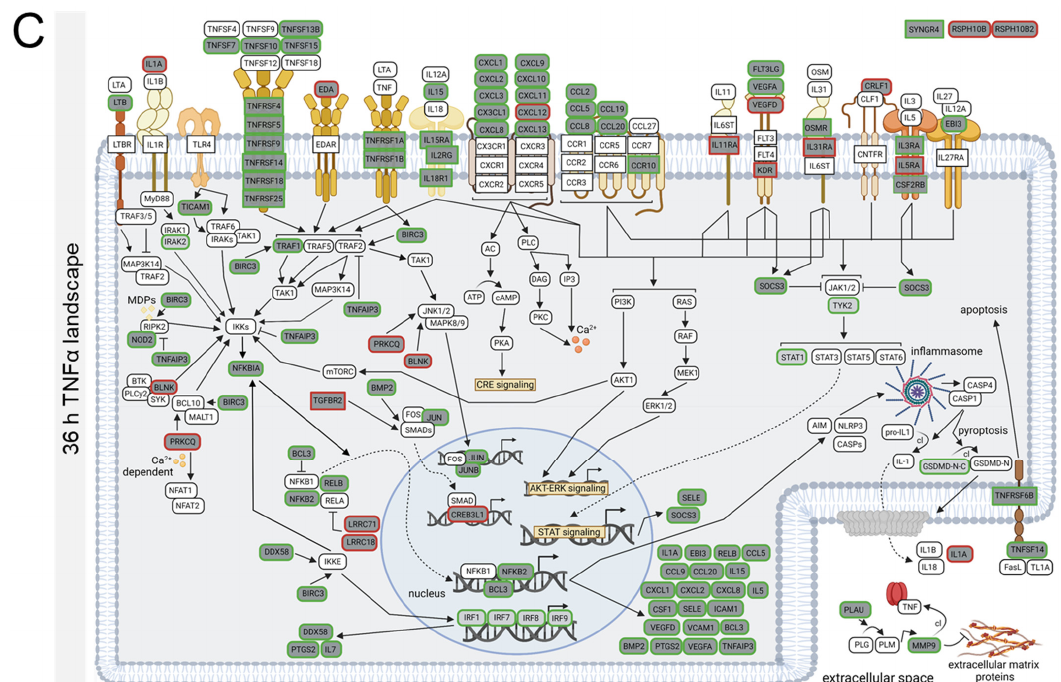
Figure 2. Molecular landscapes of the proteins encoded by the differentially expressed genes (DEGs) from the three core KEGG pathways (“Cytokine-cytokine receptor signaling”, “TNF signaling” and “NF κ B signaling”) following TNF α stimulation of human cortical spheroids for ( A ) 4 h, ( B ) 12 h and ( C ) 36 h. Protein functions and interactions were deduced based on information obtained from Uni- protKB (https://www.uniprot.org/; accessed on 1 January 2022) and Genecards (https://www.gene- cards.org; accessed on 15 January 2022). A detailed description of the protein-protein interactions occurring in these molecular landscapes can be found in Supplementary information S5. Rectangu- larly framed protein: membrane-bound receptor; protein in green or red (rounded) rectangle frame: encoded by an up- or downregulated DEG, respectively; protein in dark-gray-filled (rounded) rec- tangle: encoded by a core KEGG pathway DEG; protein in light-gray-filled (rounded) rectangle: encoded by a DEG not in the core KEGG pathways; protein in white-filled (rounded) rectangle: not encoded by a DEG. Black arrows: stimulation or induction; inhibition arcs: inhibition; dotted arrows: translocation; fading arrow: enzymatic conversion; cl: cleavage.